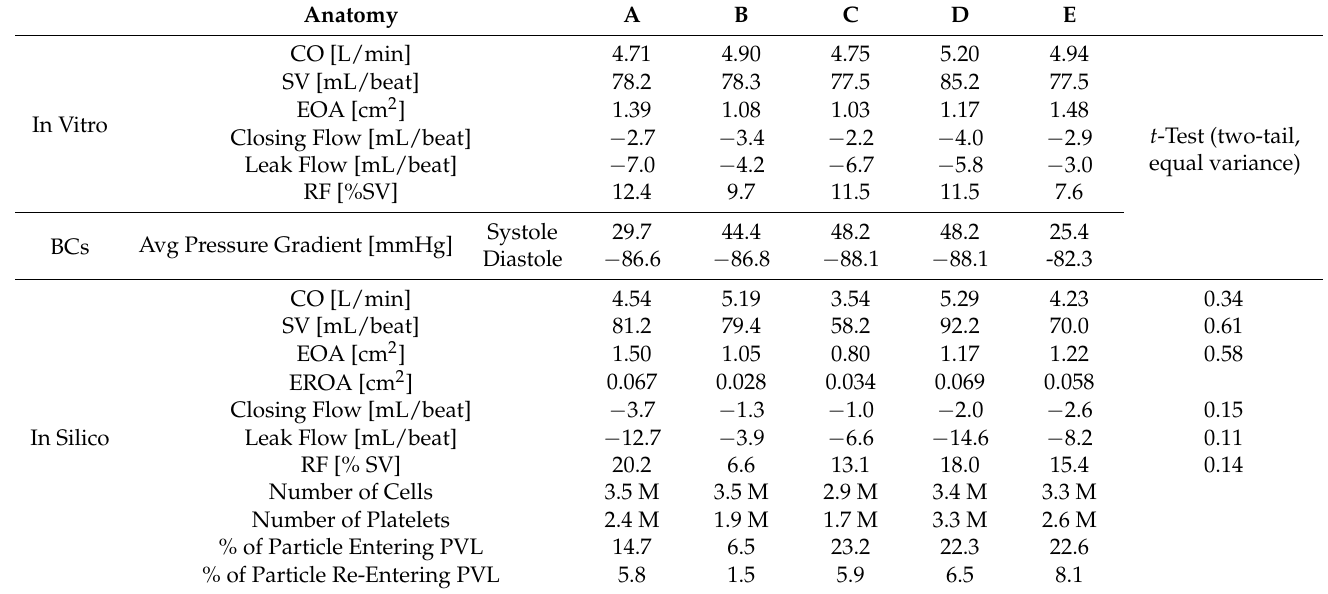
Table 1. Compilation and comparison of the in vitro flow parameters to the in silico results and parameters.